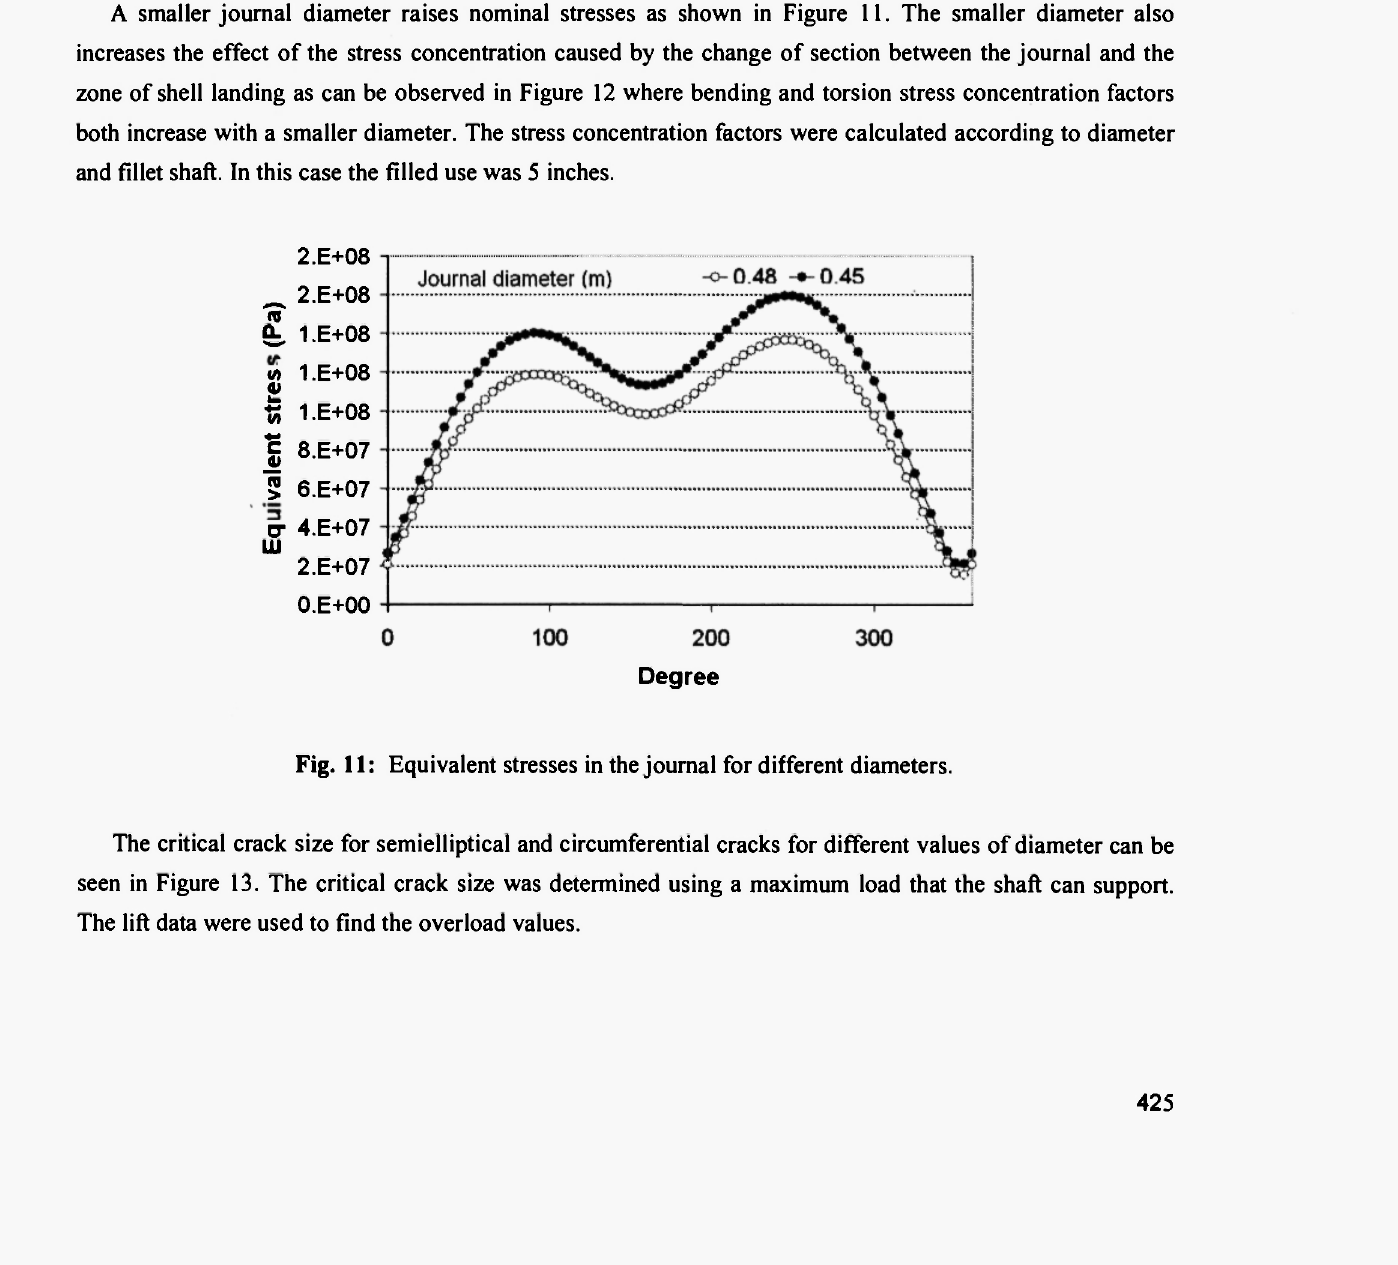
Fig. 11: Equivalent stresses in the journal for different